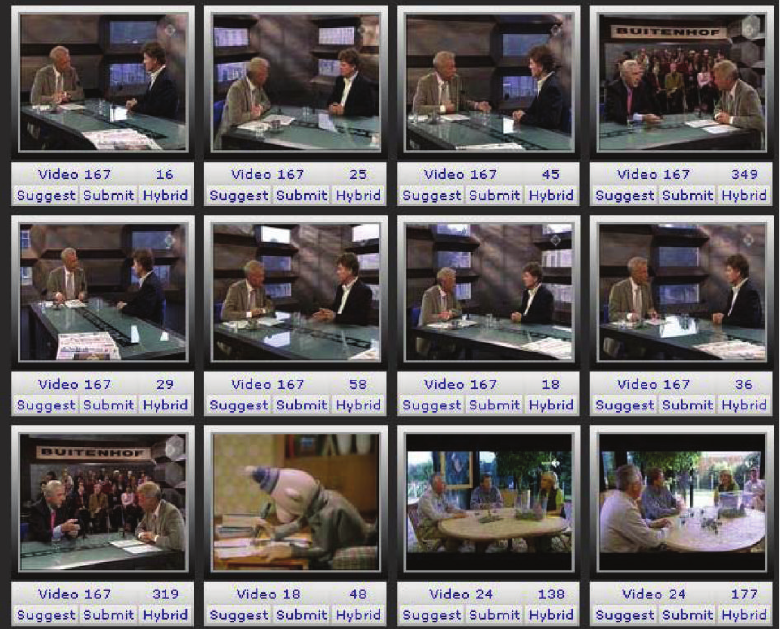
Figure 13: Query by image example. Relations from the weighted graph are used to realize the query. The input image is the one on the left top